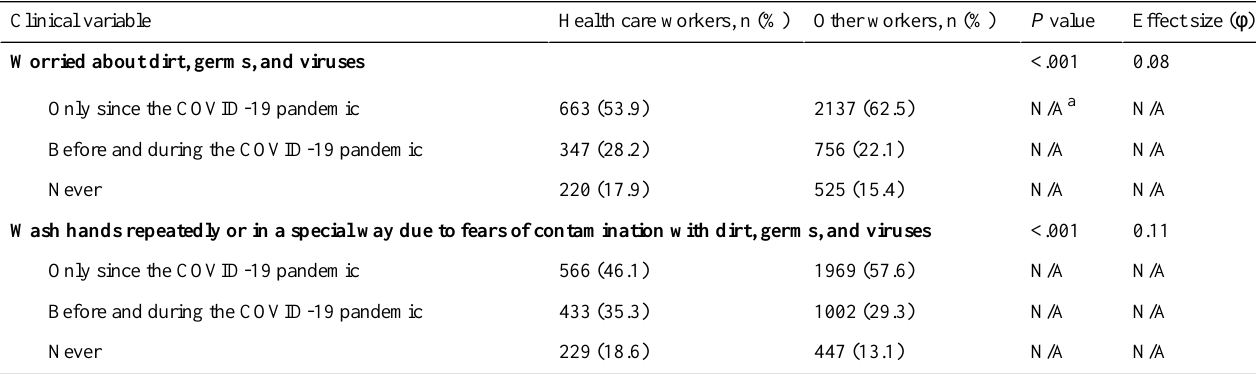
Table 3. Chi-square test of association between worker type and manifestation of obsessive-compulsive